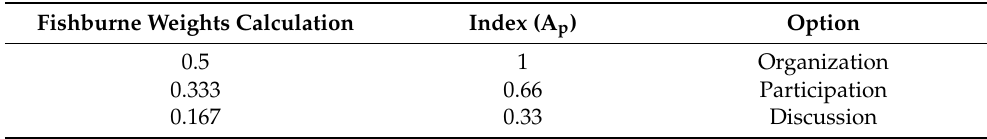
Table 27. Index system for type of active participation.